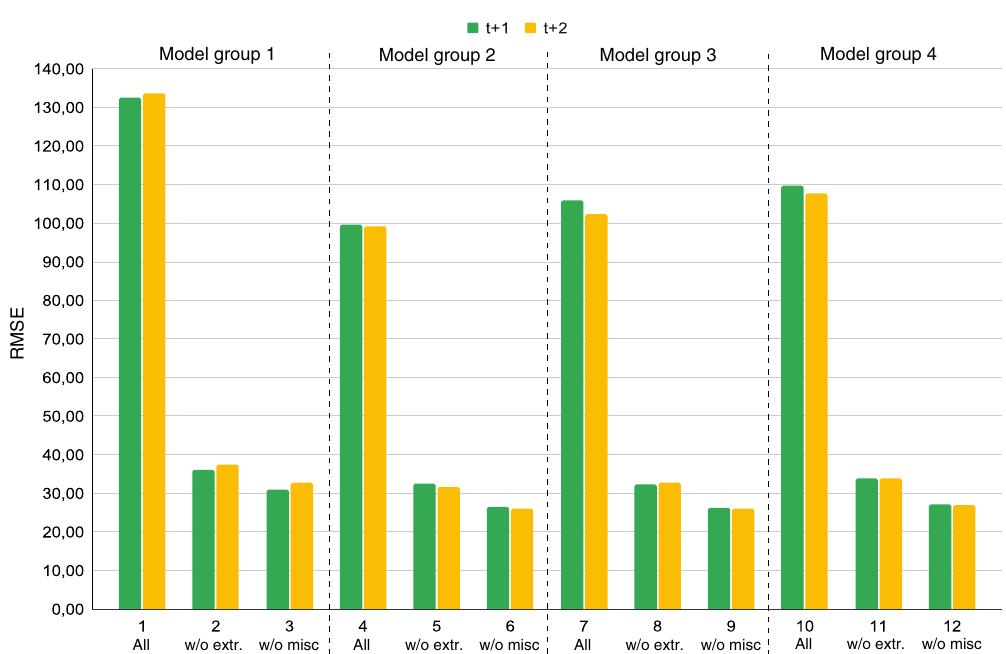
Figure 5. RMSE effect of model performances including misc samples (1, 4, 7, 10), samples where the extreme outlier element were removed (2, 5, 8, 11) and misc samples completely removed (3, 6, 9,